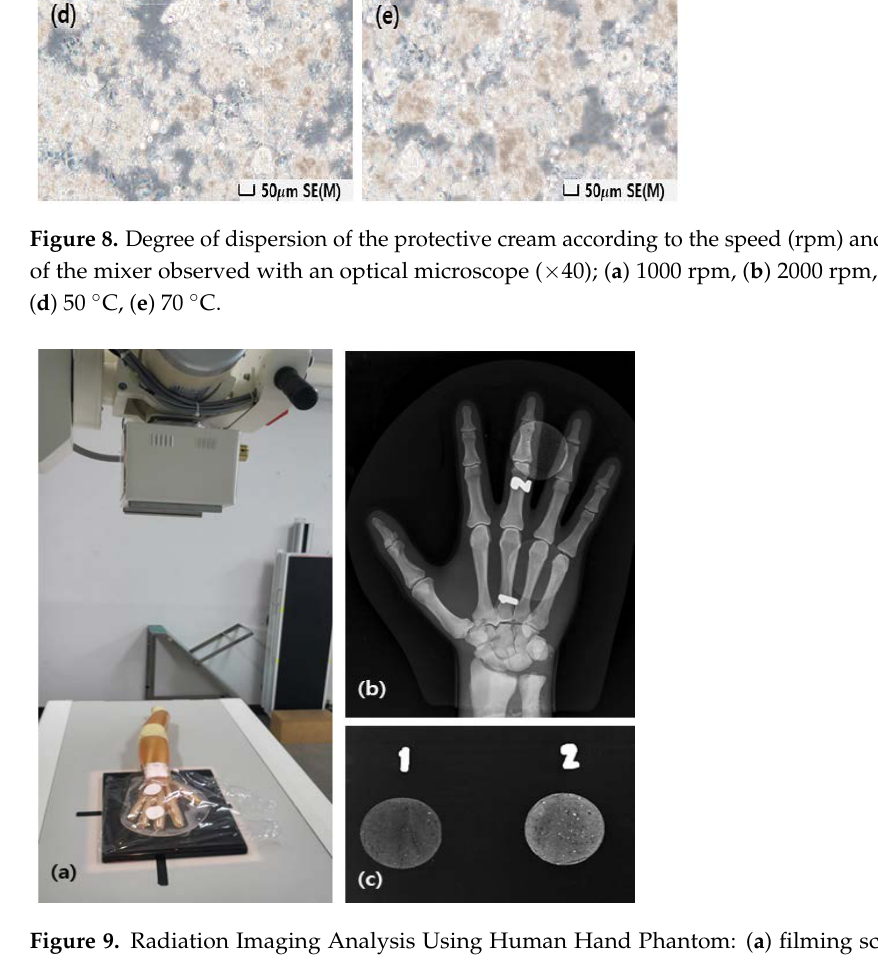
Figure 9. Radiation Imaging Analysis Using Human Hand Phantom: ( a ) filming scene to obtain an X-ray image of protective cream; ( b ) image of 1.0 mm protective cream on a phantom; ( c ) image showing different concentrations of 0.1 mm barium sulfate (1: 20 wt%, 2: 30 wt%).